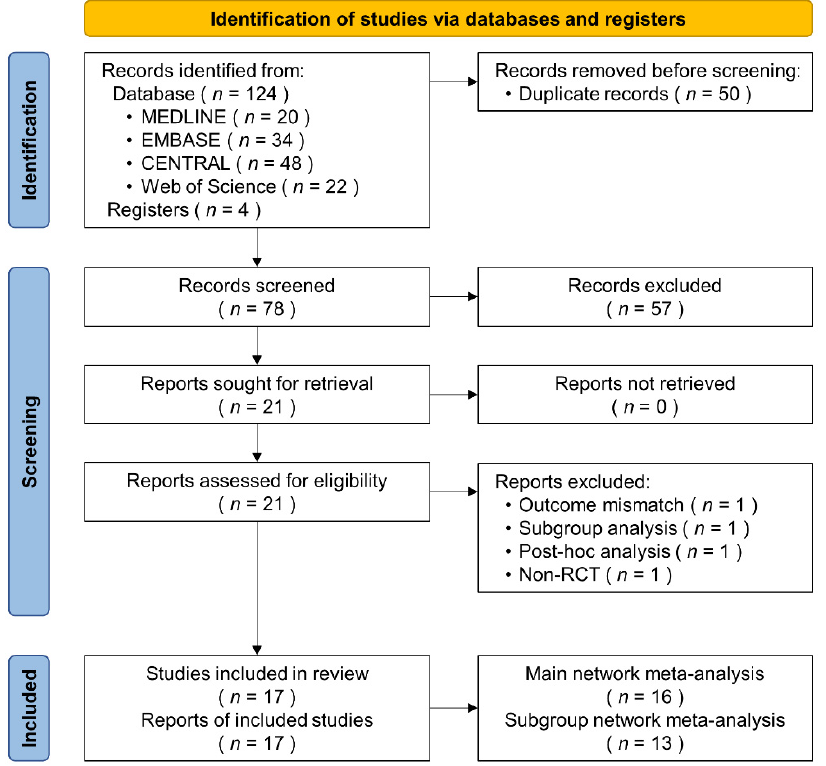
Figure 1. Flow diagram of the included studies. The PRISMA flow diagram depicts the phases of the systematic review and shows the number of records identified, screened, included, and excluded. RCT, randomized controlled trial.